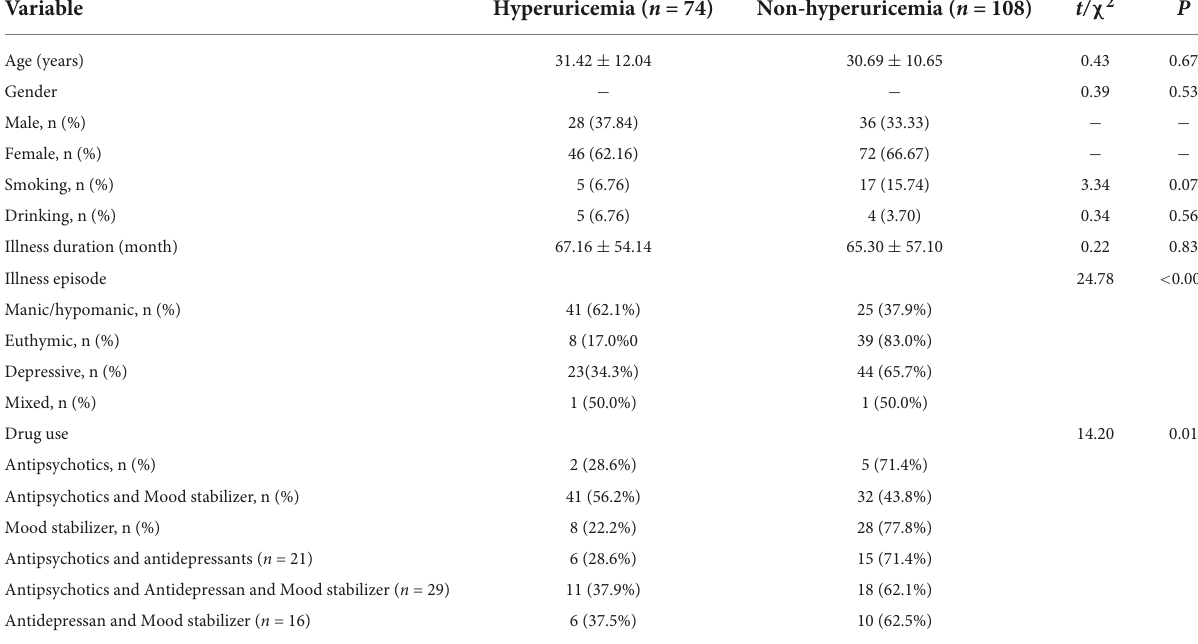
TABLE 3 Socio-demographic and clinical characteristics of BPD with